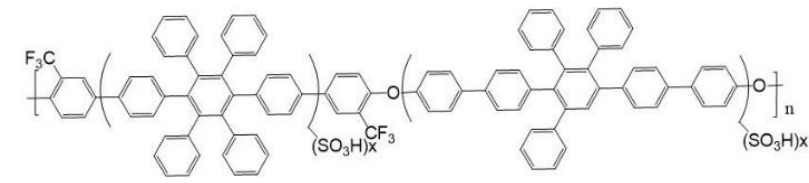
Figure 1. Sulfonated polymer structure of SA8 [24] .